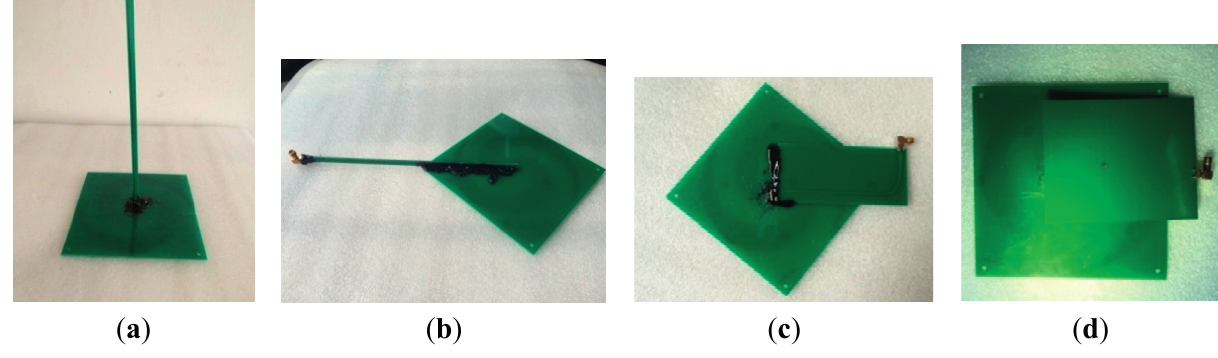
Figure 8. Connections of the ESA and baluns. ( a ) vertically; ( b ) with an I-shaped balun; ( c ) with an L-shaped balun; ( d ) with a C-shaped